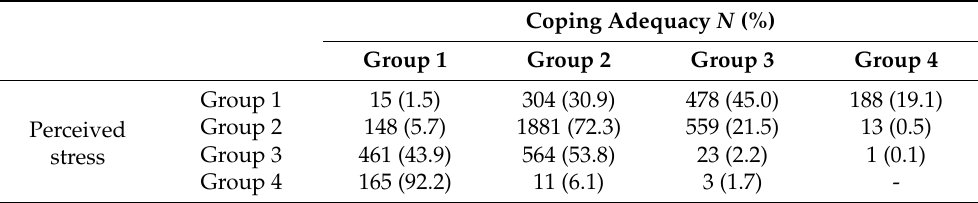
Table 2. Contingency table between the subgroups of perceived stress and coping